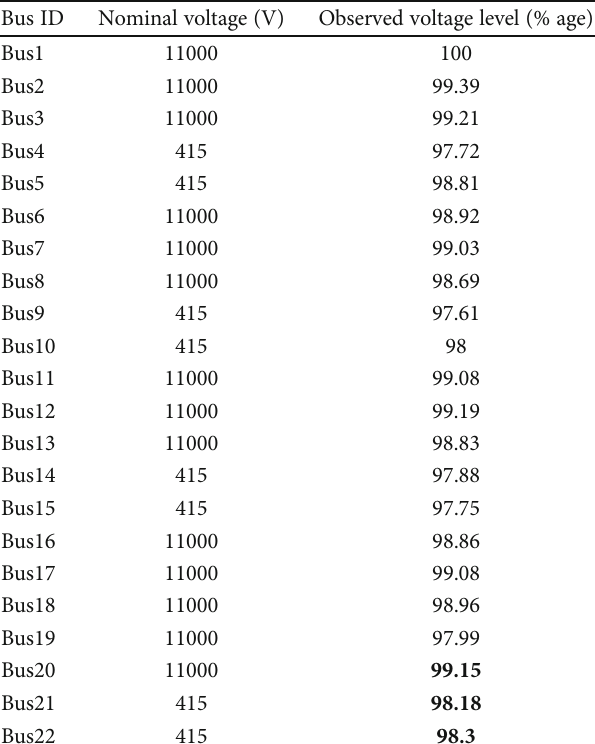
Table 10: Branch losses comparison of Case 1 and Case